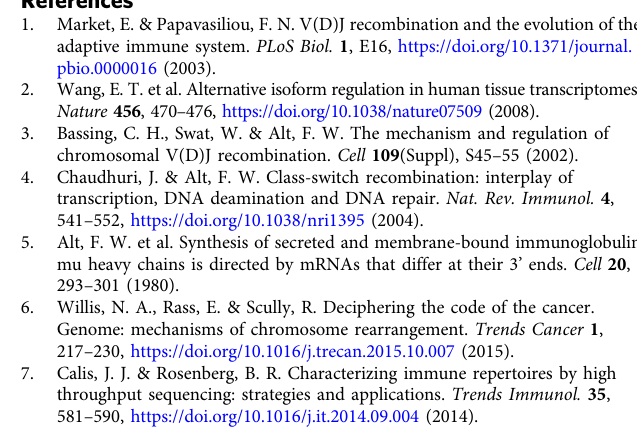
Statistics . Figure 2.c, a Pearson correlation was performed. Supplementary Fig. 5h, a paired Wilcoxon test was performed when comparing Jaccard similarity coef fi - cient for the 250 most abundant genes chosen from within each respective cell type